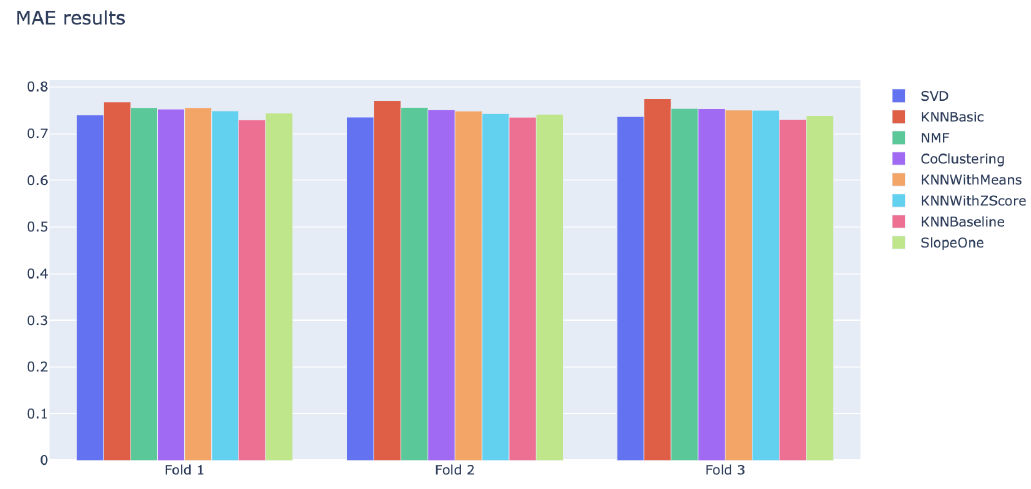
Figure 9. MAE results using Model-based collaborative filtering.